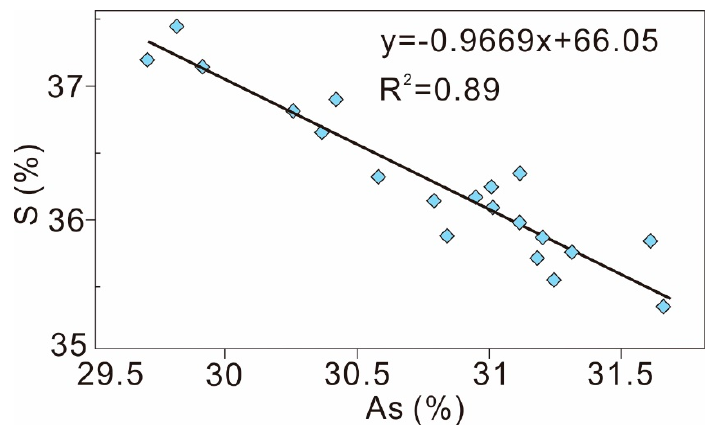
Figure 7. Distributions and relationship of As and S atomic percentages in the arsenopyrite [10].